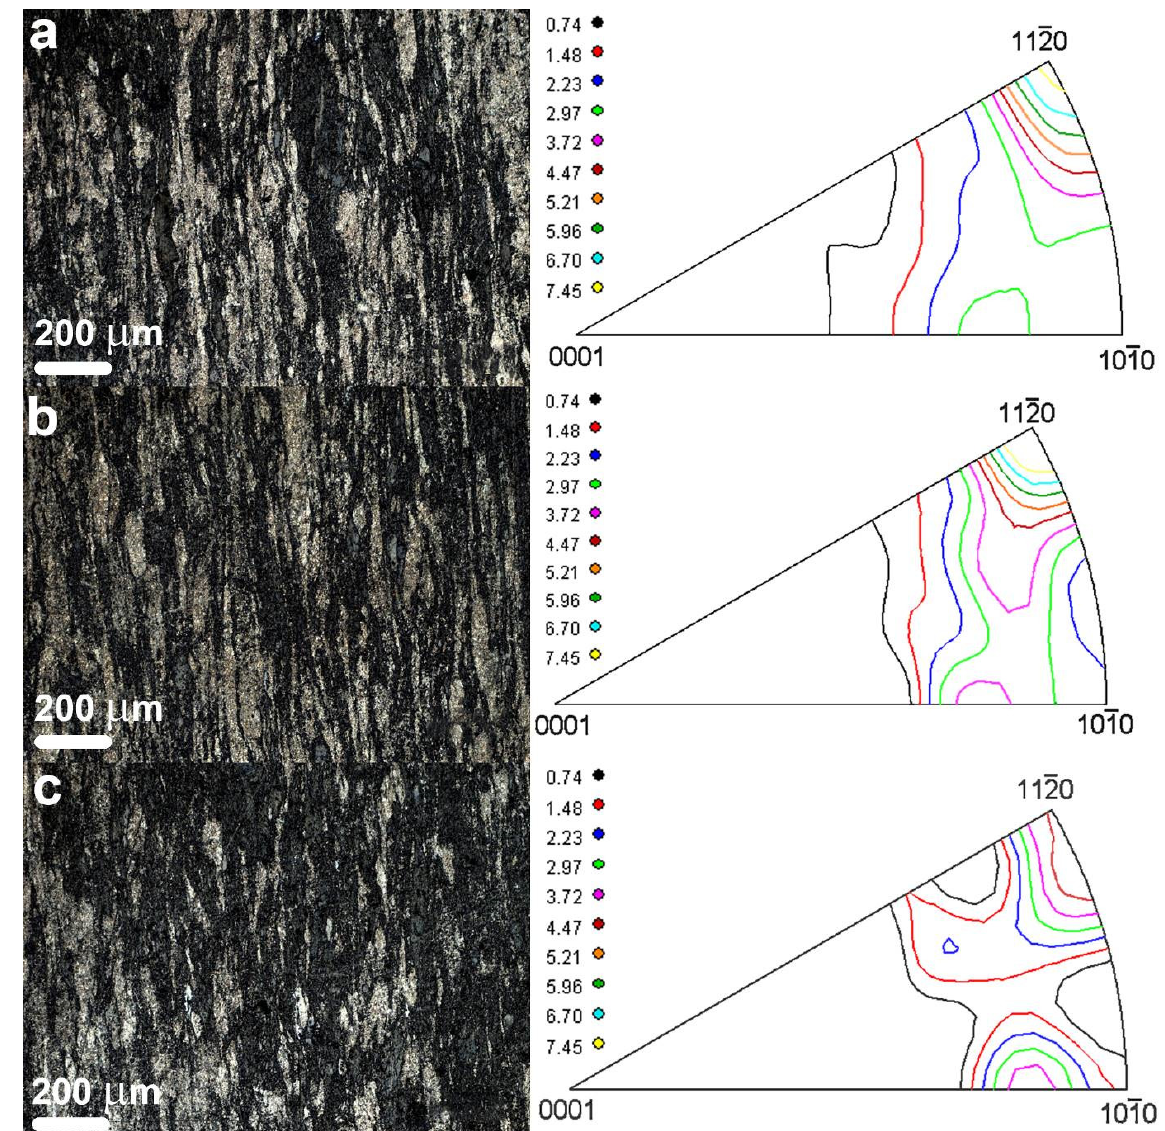
Figure 7. Evolution of rod texture and microstructure along extrusion axis: ( a ) 1 cm from die beginning, ( b ) 3 cm from die beginning, and ( c ) 5 cm from die beginning.